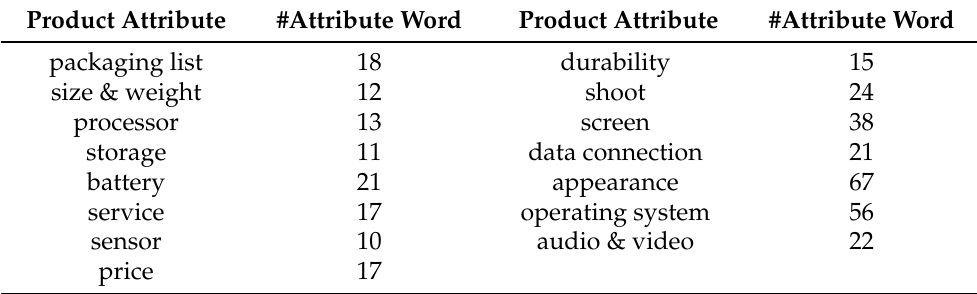
Table 2. Product attributes and the number of attribute words for each product